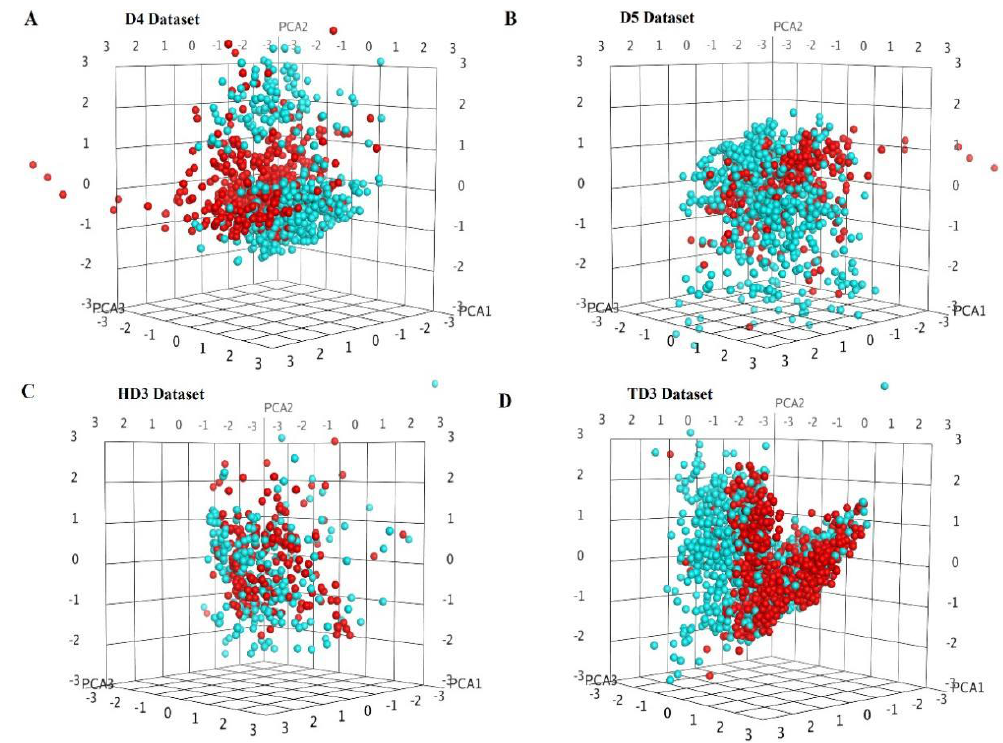
Figure 3. Structural similarity analysis based on principal component analysis. ( A ) ACPs mixed dataset D4. ( B ) ACPs mixed dataset D5 (data of negative natural peptides were obtained from Swissprot). ( C ) Hemolytic peptide mixed dataset HD3. ( D ) Toxic peptide mixed dataset TD3. Blue indicates negative data and red indicates positive data.